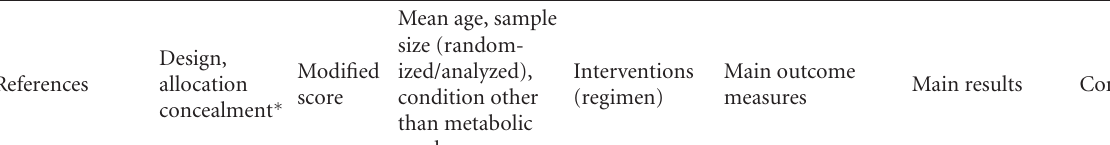
Table 1: Summary of clinical studies of mind-body